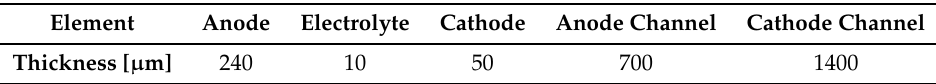
Table 1. Thicknesses of the cell components.